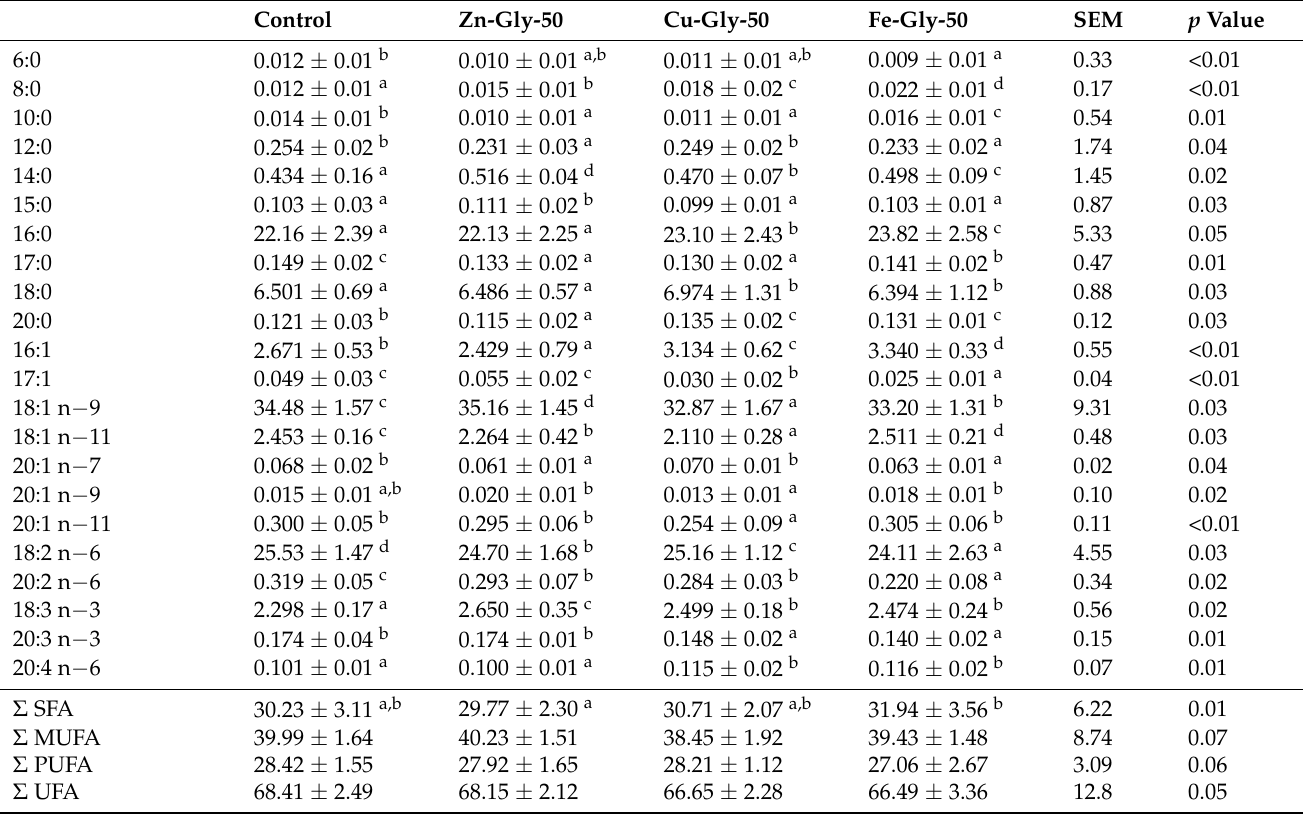
Table 5. Fatty acid profile (g/100 g of total fatty acids) and dietetic values of thigh meat samples—treatment I (50% of the mineral in the form of